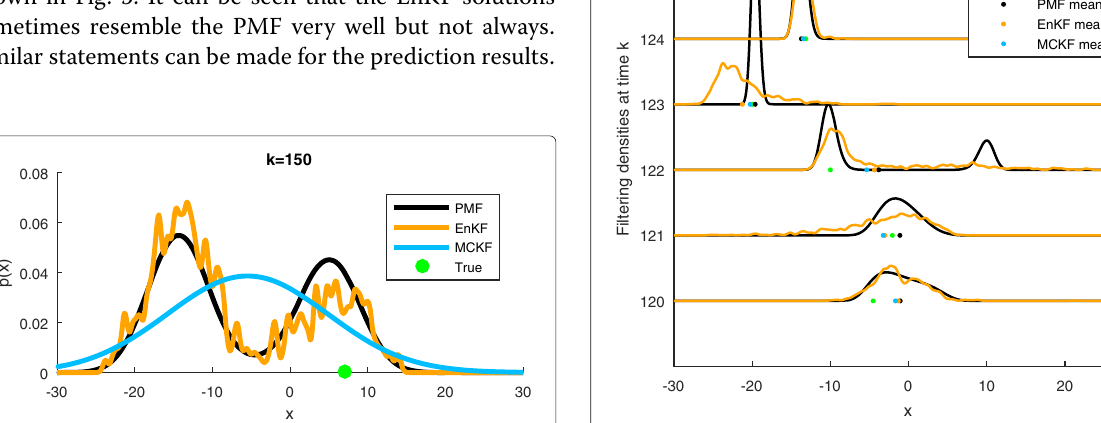
Fig. 3 Prediction densities p ( x k | y 1: k − 1 ) by the PMF, EnKF, and MCKF for k = 150. The true state is illustrated with a greendot . The PMF serves as reference solution